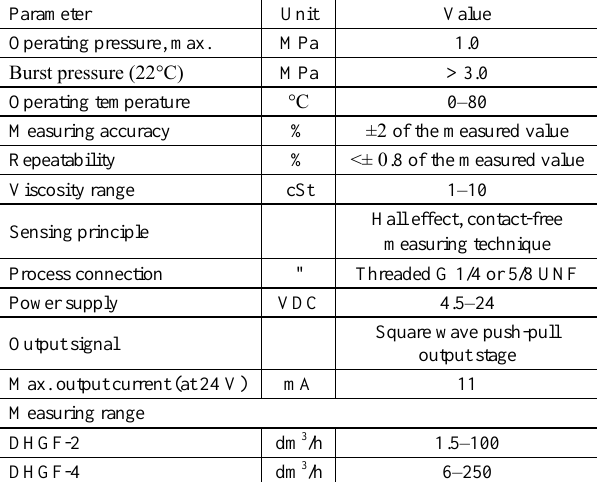
Fig. 3. Flow meter DHGF-2 from Meister [29] Table 1. Technical data of DHGF series flow meters